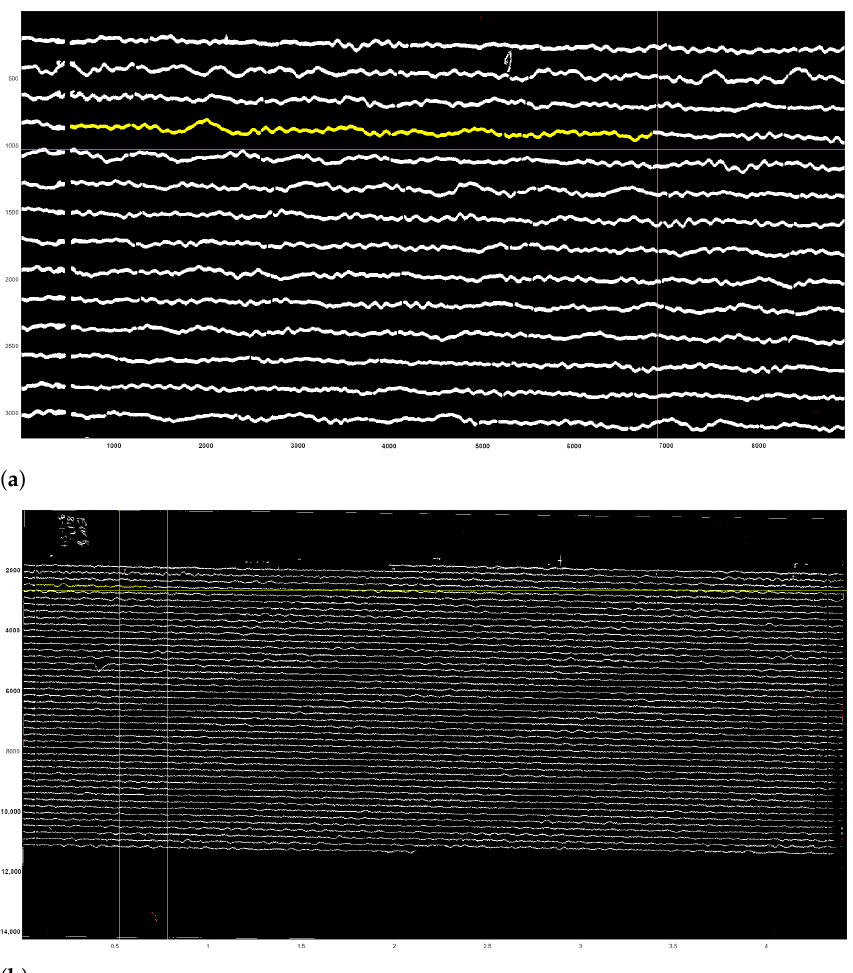
Figure 11. Results of the scanned seismogram classification processed by DigitSeis. ( a ) Results of the classified image with shown yellow segments of the identified trace (enlarged